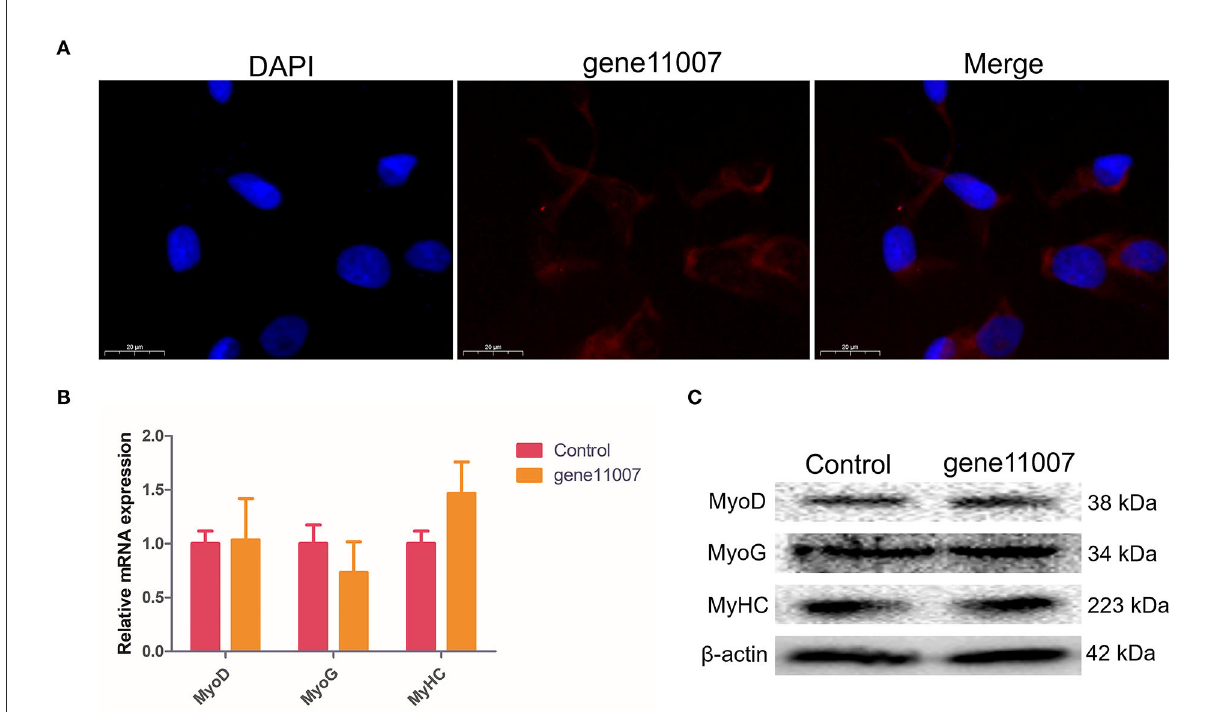
FIGURE8 Detection of buffalo myoblasts differentiation-related proteins by overexpression of gene11007. (A) The results of fluorescence in situ hybridization showed that gene11007 was mainly localized in the cytoplasm. (B,C) The expression of marker genes MyoD, MyoG and MyHC for myocyte differentiation after 4 days of culture were measured by qPCR and western blotting. The values are means ± SEMs for three individuals. *represents P <